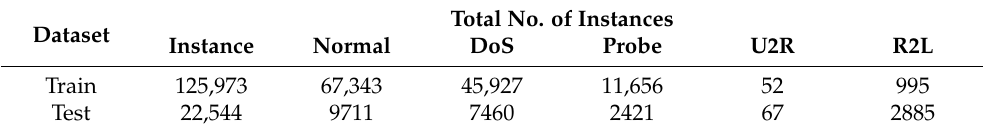
Table 1. Composition of the NSL-KDD.